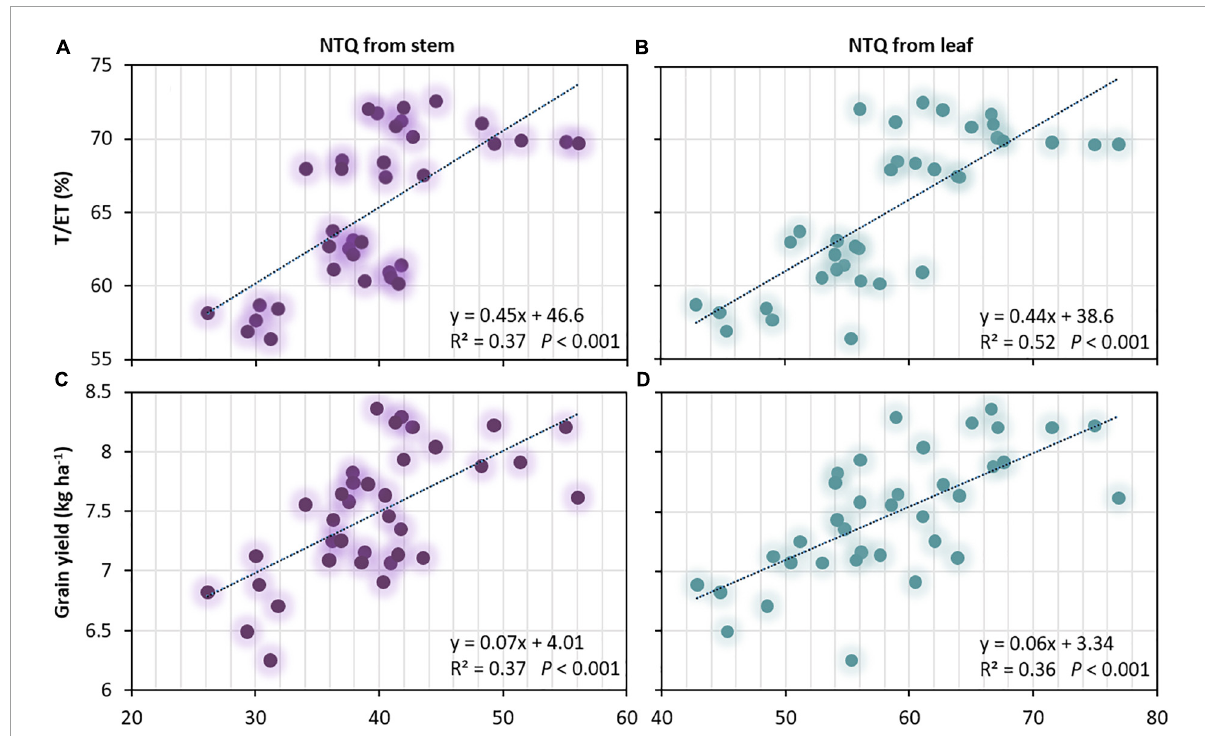
FIGURE6 Ratio of transpiration to evapotranspiration (T/ET) and grain yield (GY) both followed in a positive linear regression curve with the quantity of transferred N (NTQ) from (A,C) stem and (B,D) leaf of spring wheat across 2019–2020,